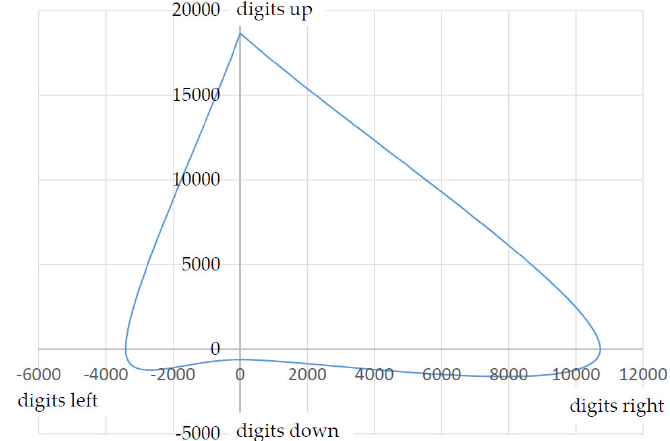
Figure 12. Force curve (force to digit); interpolated values.